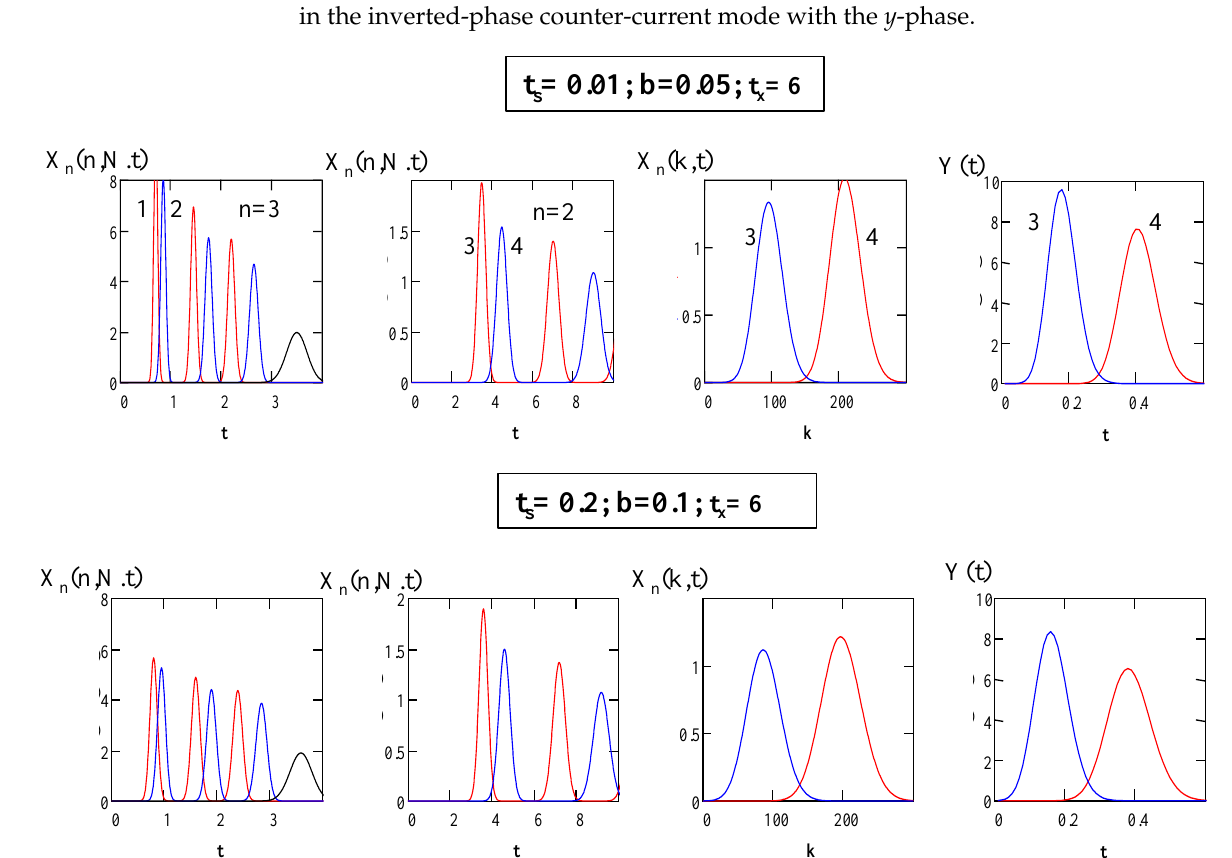
Figure 4. Simulation of the separation of the mixture containing four compounds ( K D 1 = 0.4, K D 2 = 0.7, K D 3 = 6, K D 4 = 8) on the closed-loop setup with N = 300, N ec = 200, and S f =